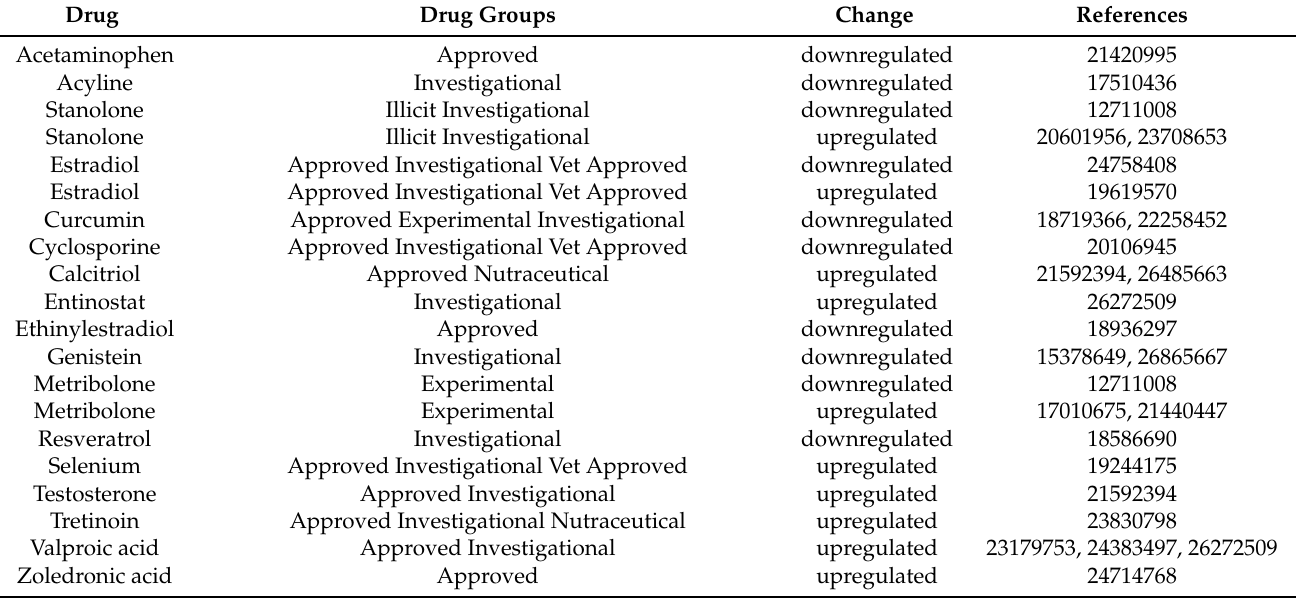
Table 7. Drugs that alter expression TMPRSS2.